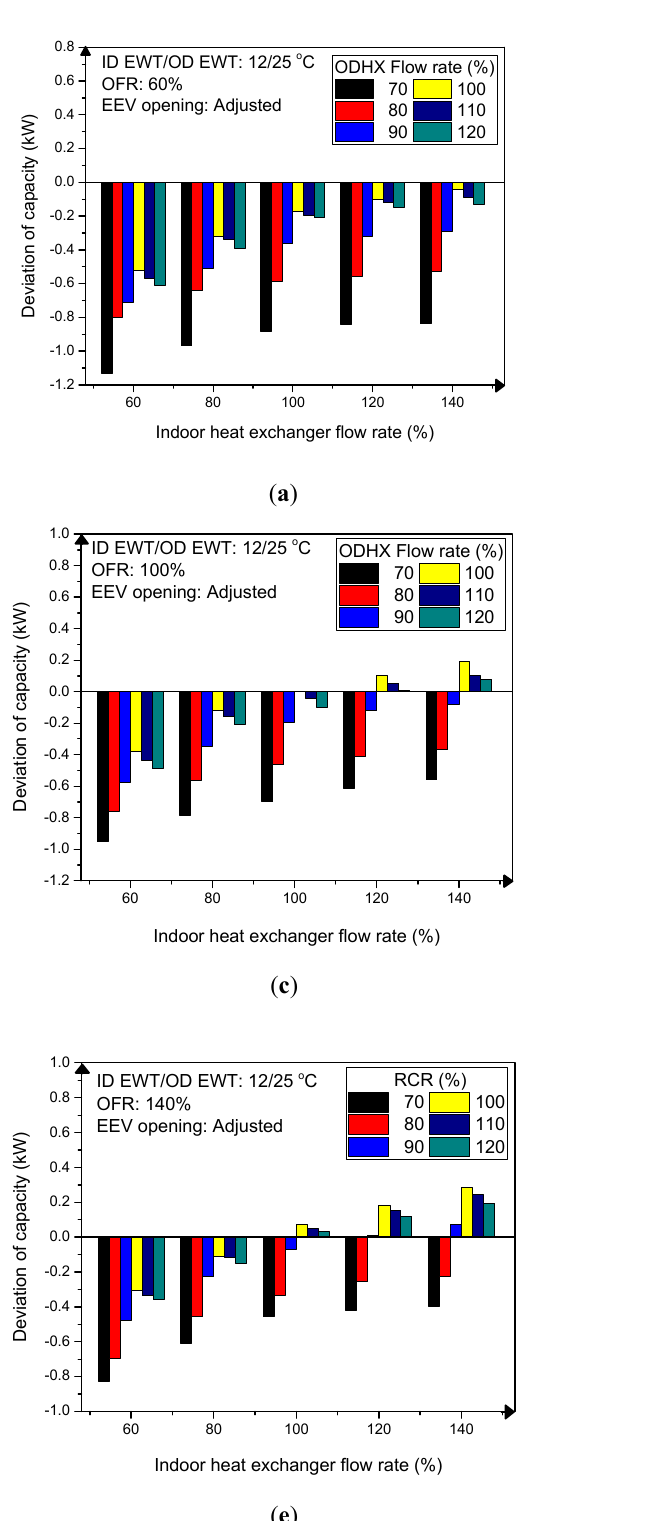
Figure 8. Change in cooling capacity according to refrigerant charge and flow rate of secondary fluid in indoor and outdoor